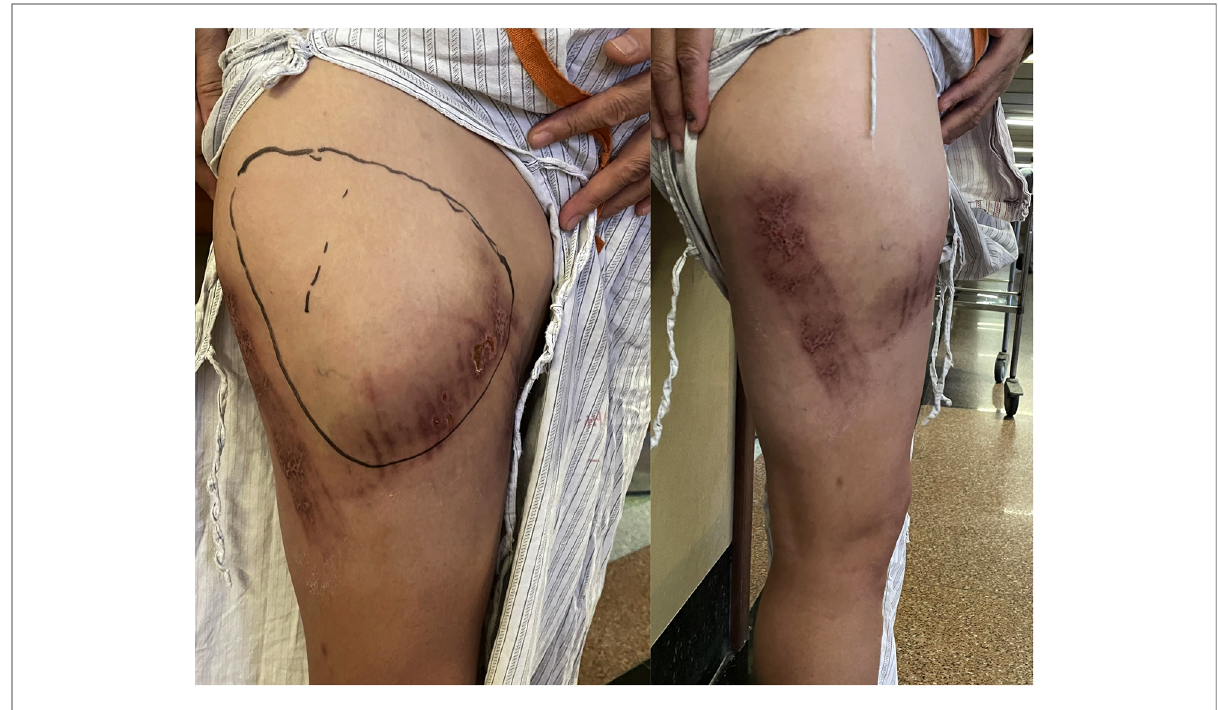
FIGURE 1 Clinical images. Multiple contusions, bruising, and a wide range of skin fl uctuations on the anterolateral right